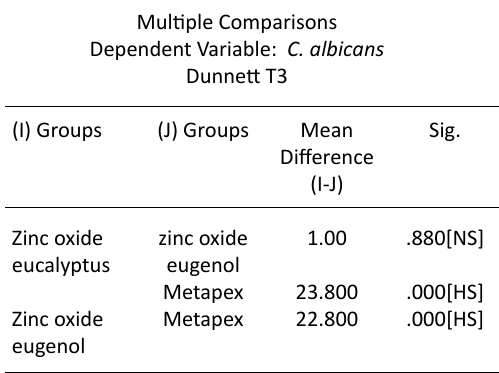
Table 6. Multiple Comparisons of antibacterial effect of